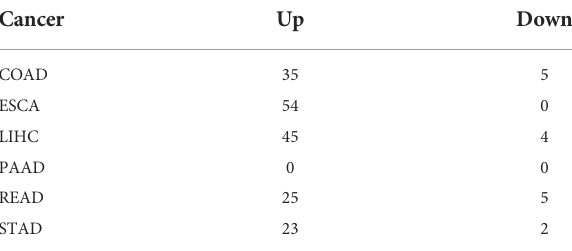
TABLE 1 The differential expression of ER stress